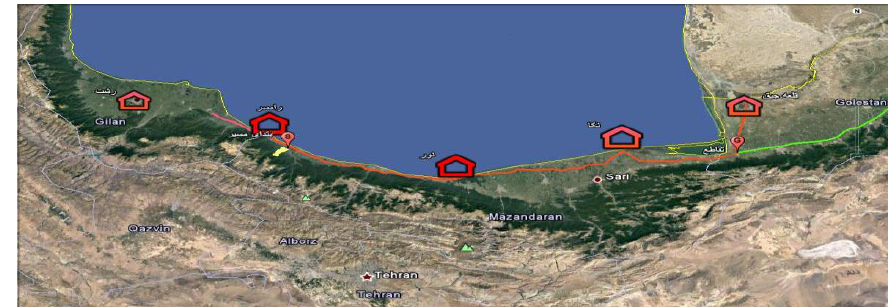
Figure 1. Pipeline of Iran gas transfer zone 9